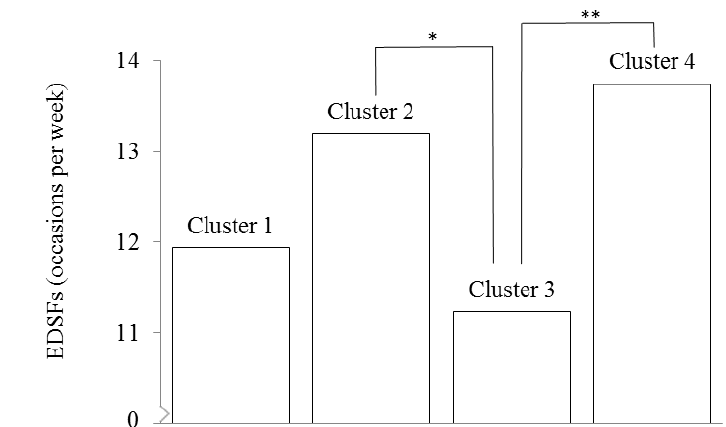
Figure 2. Mean energy-dense snack food (EDSF) occasions per week according to cluster membership; * p < 0.05, ** p < 0.05, uncorrected means (SD) are presented ( n = 888), ANCOVAs: n = 864, Cluster 1 = “high covert control and rewarding”; Cluster 2 = “low covert control and non-rewarding”; Cluster 3 = “high involvement and supportive”; Cluster 4 = “low involvement and